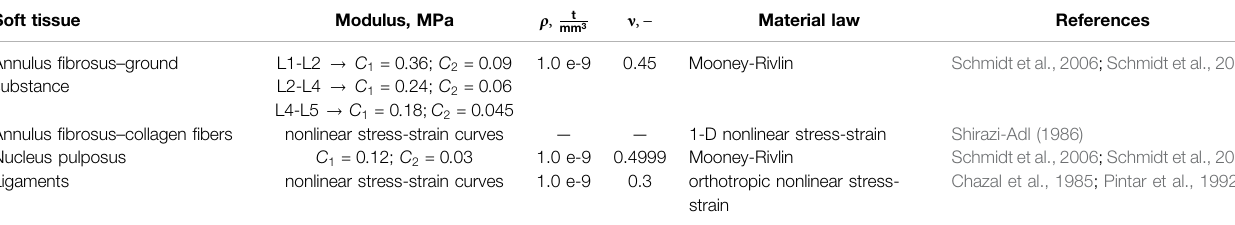
TABLE 1 | Material properties of soft tissues in the lumbar spine